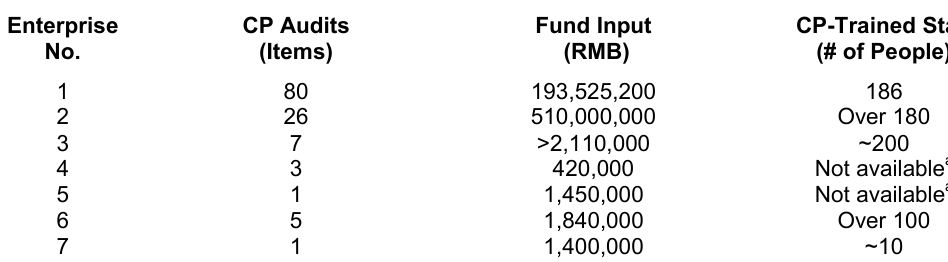
Some CP Information in Seven Visited